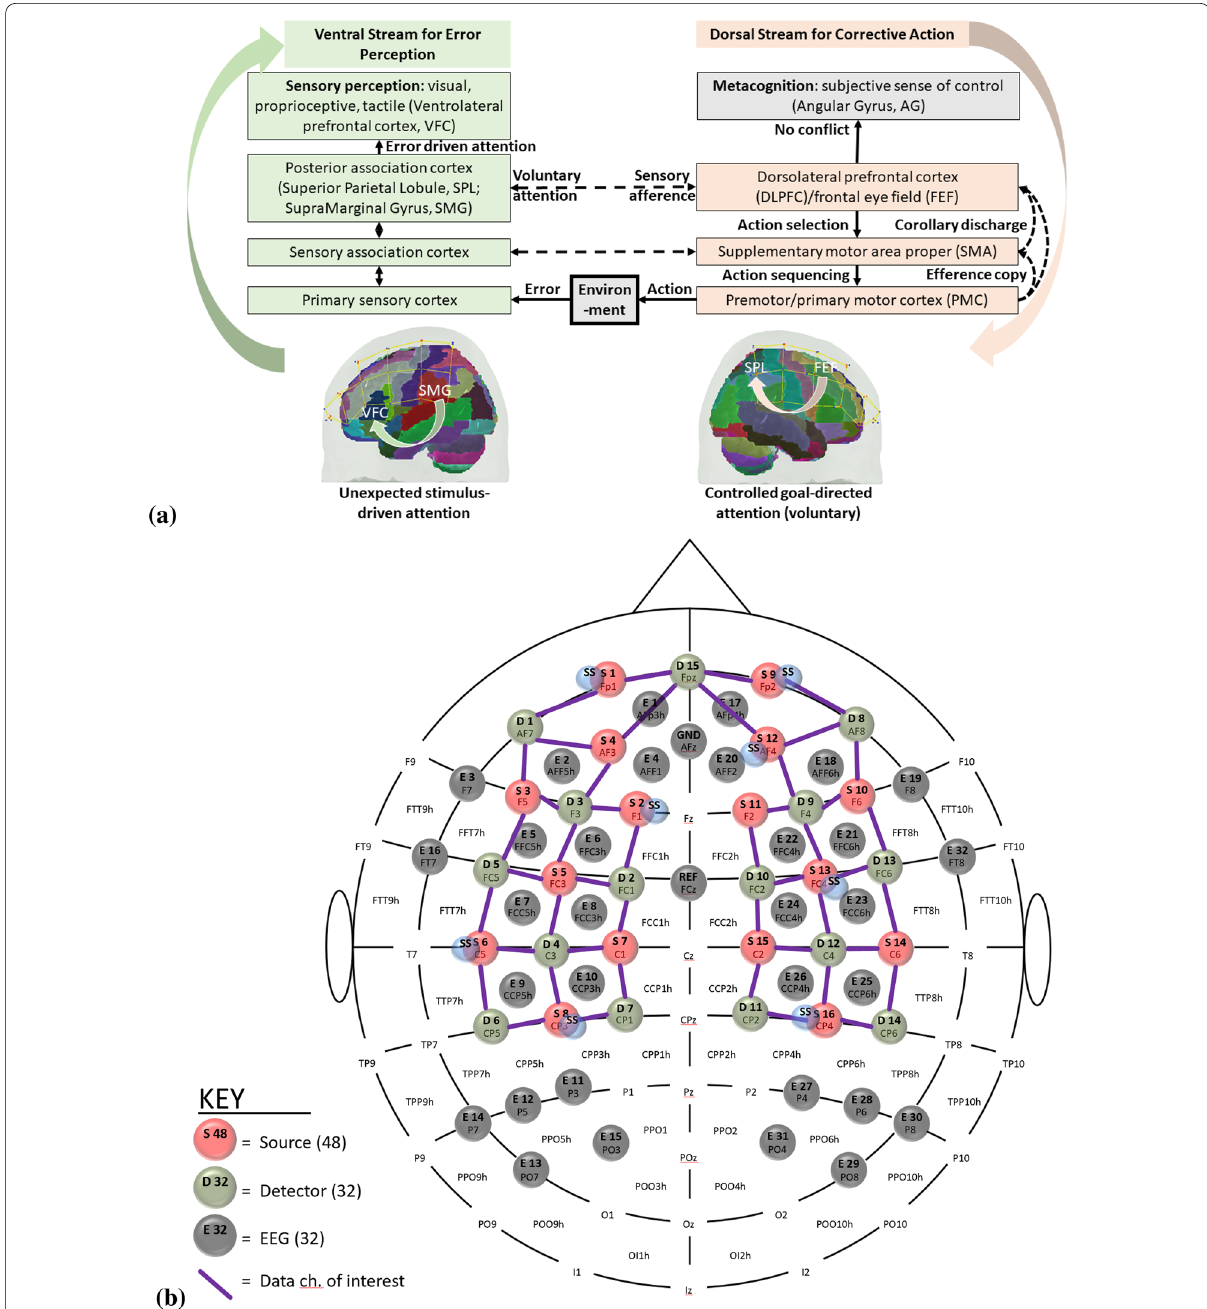
Fig. 1 a Perception action system for error-related mental processes during laparoscopic surgical training. Portable neuroimaging allowed investigation of the brain regions based on the optode montage (see Fig. 1b) and its sensitivity profile (see Fig. 1c) that included ventrolateral prefrontal cortex (VFC), superior parietal lobule (SPL), supramarginal gyrus (SMG), angular gyrus (AG), dorsolateral prefrontal cortex (DLPFC), frontal eye field (FEF), premotor and primary motor cortex (PMC). A distinction is made between the unexpected stimulus (error) driven attention and the controlled goal directed attention in the frontoparietal network system. b Multi-modal (fNIRS–EEG) sensor montage including short-separation (labelled SS in light blue ellipses) channels. The red filled circles are the fNIRS sources, the green filled circles are the fNIRS detectors, the grey filled circles are the EEG electrodes, the violet lines are the optode pairs for the fNIRS channels. c Probe sensitivity values in the 0.01 to 1 range are displayed logarithmically as 2 to 0 in log10 units in the color bar (left panels). The projection of the fNIRS channels on the cortex are shown with − black arrows (left panels) along with the Automated Anatomical Labelling (AAL) of the brain regions in color (right panels). Table 1 shows the AAL of the cortical areas underlying fNIRS channels (source #–detector # pair). d Experimental setup in the laboratory with the subject performing the FLS "suturing and intracorporeal knot-tying" task (FLS complex